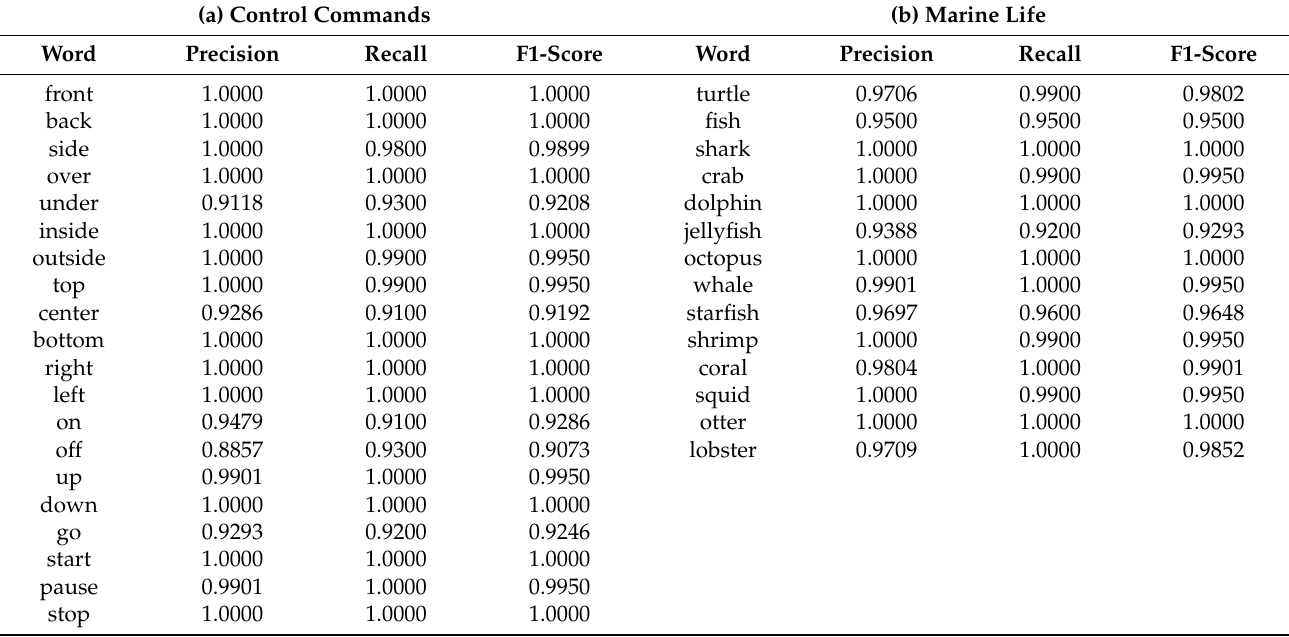
Table A3. Precision, recall, and F1-score performance of in four noise environments. (a)